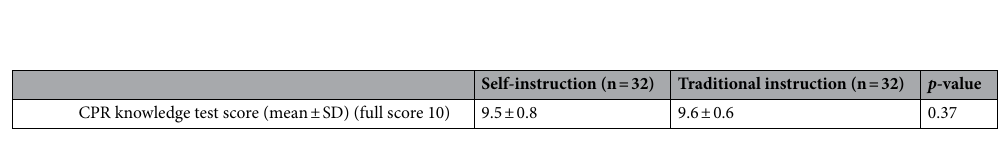
Table 3. The scores of knowledge test between groups. CPR, cardiopulmonary resuscitation; SD, standard deviation.